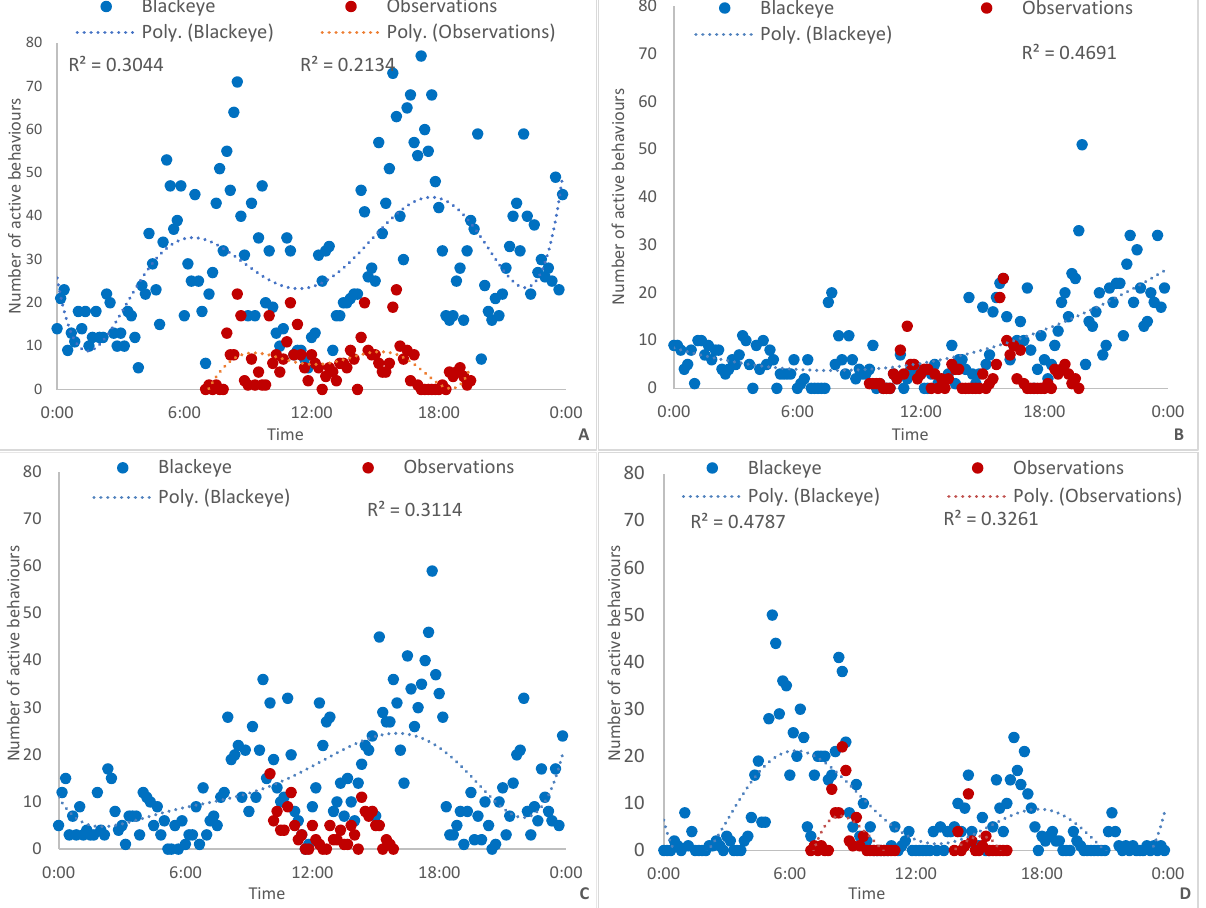
Figure 1. Frequency of active behaviours for red panda at three zoos, in 10 min intervals. The red lines show when direct observations were carried out. R 2 values are calculated from an nth order polynomial line. ( A ) All zoos combined; ( B ) Auckland Zoo; ( C ) Hamilton Zoo; ( D ) Currumbin Wildlife Sanctuary.